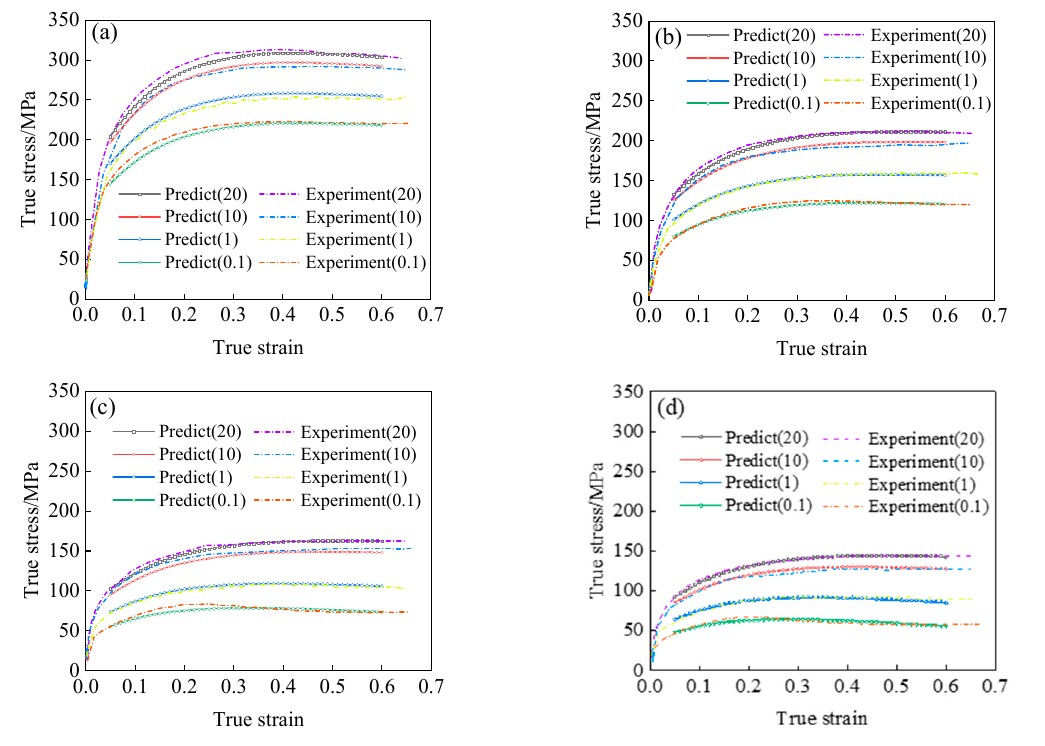
Figure 16. The predicted results of the modified Arrhenius-type model: ( a ) T = 1073 K, ( b ) T = 1223 K, ( c ) T = 1323 K, ( d ) T = 1373 K.